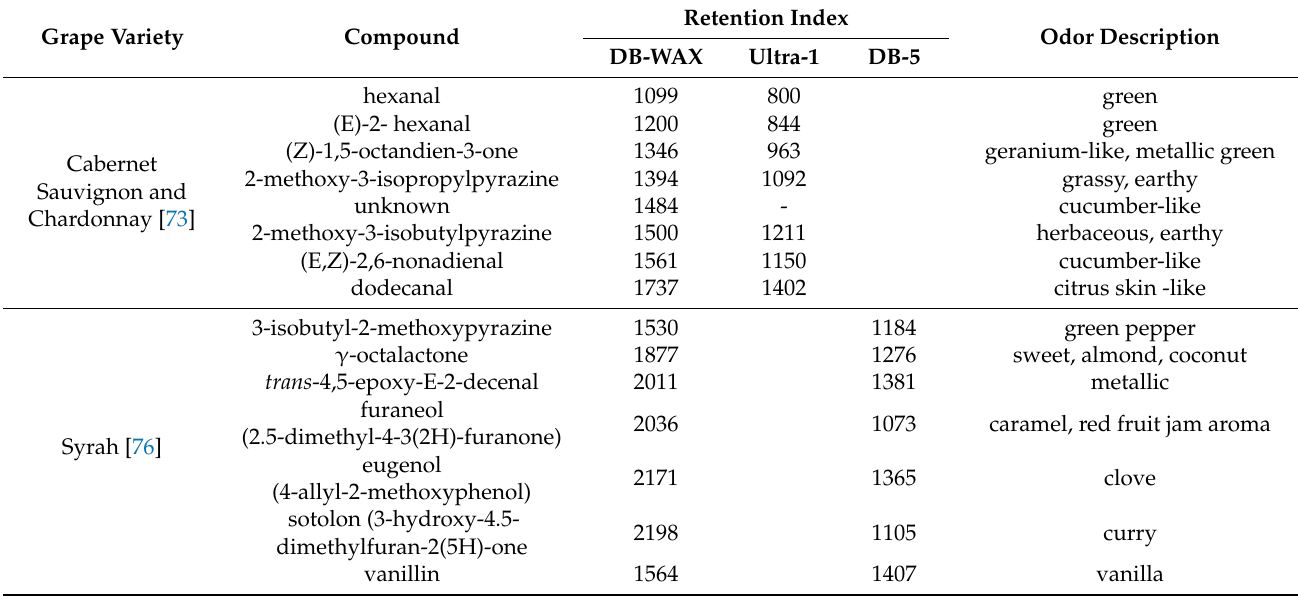
Table 11. Identification of aromatic compounds in grape stem